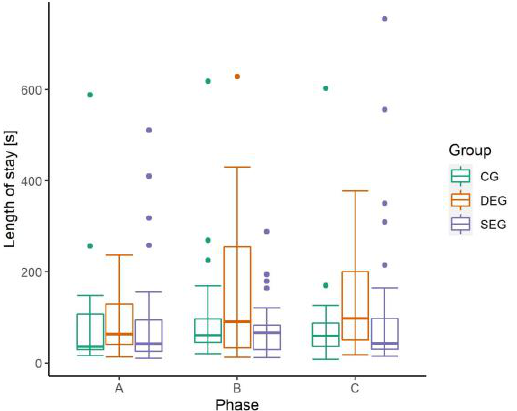
Figure 5. Boxplots with dots indicating individual outliners of the length of stay(s) of laying hens in the observed area in the winter garden during different phases (Phase A: peak of laying period, weeks of life (LW) 31/32; Phase B: middle of laying period, LWs 50/51; Phase C: end of laying period, LWs 64/65/71) and in three groups (CG = control group, SEG = single enrichment group, DEG = double enrichment group).